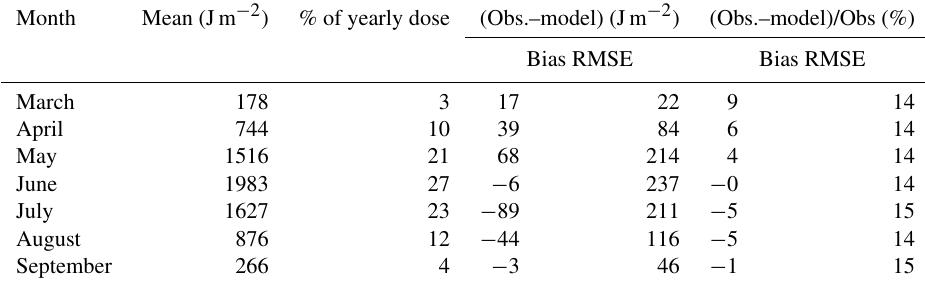
Table 1. Monthly mean of the daily erythemal doses, participation of the monthly sum of daily doses in the yearly (February–October) sum of the daily doses, monthly mean difference between the observed and modeled doses, and corresponding root mean square error (RMSE), monthly mean difference between the observed and modeled doses as a percent of the observed doses, and corresponding RMSE. The results are from modeled and observed daily doses at Hornsund for the period